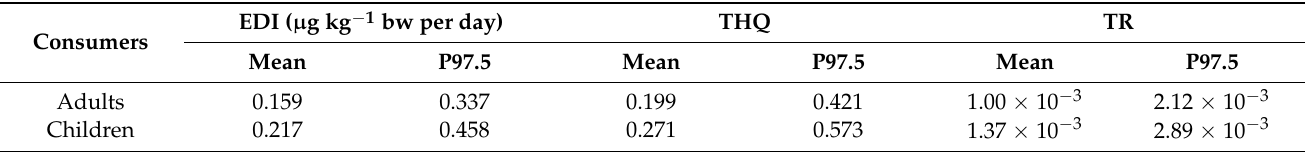
Table 2. EDI and THQ of Cd for vegetable